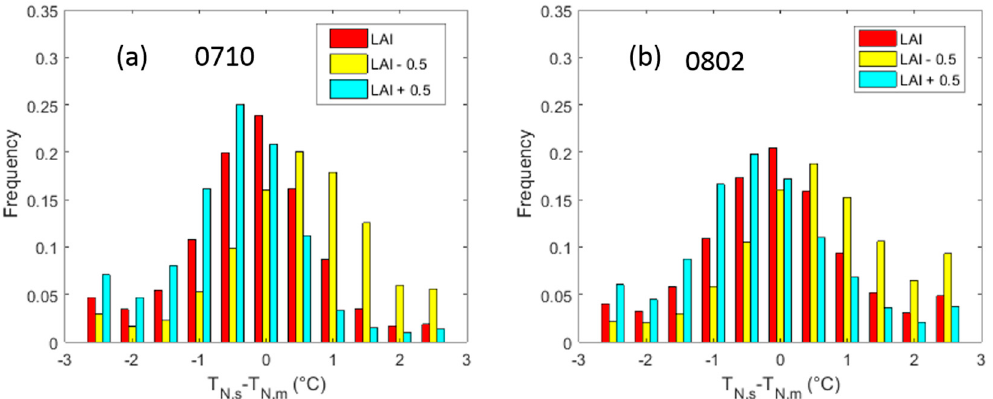
Figure 7. Histograms of the differences in temperature between the simulated and observed values with different LAI errors correspond to ( a ) 10 July 2012 and ( b ) 2 August 2012.